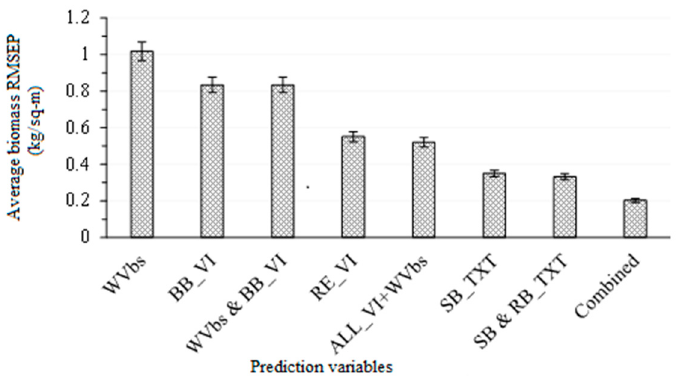
Figure 8. The red-edge vegetation indices significantly improved the accuracy of ABGB estimation to average RMSEP: 0.55 kg/m 2 . The combination of red-edge vegetation indices with broadband vegetation indices, as well as single wavebands, did not significantly improve the accuracy of estimating grass ABGB in this study. When single-band grey level co-occurrence texture matrices were used the ABGB prediction accuracy significantly improved (average RMSEP: 0.35 kg/m 2 ). In comparison, the combination of single-band and band-ratio texture models did not significantly improve the accuracy of estimating ABGB. When all variables were combined (red-edge and texture models), optimal accuracies (average RMSEP: 0.2 kg/m 2 ) were obtained in this study.